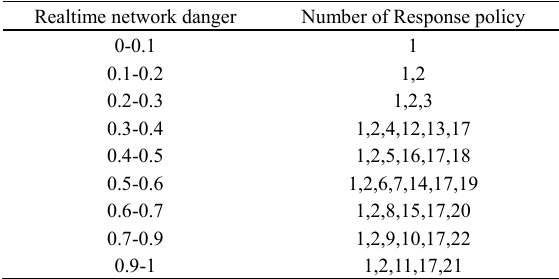
Table 2. The realtime network danger and corresponding response policies Realtime network